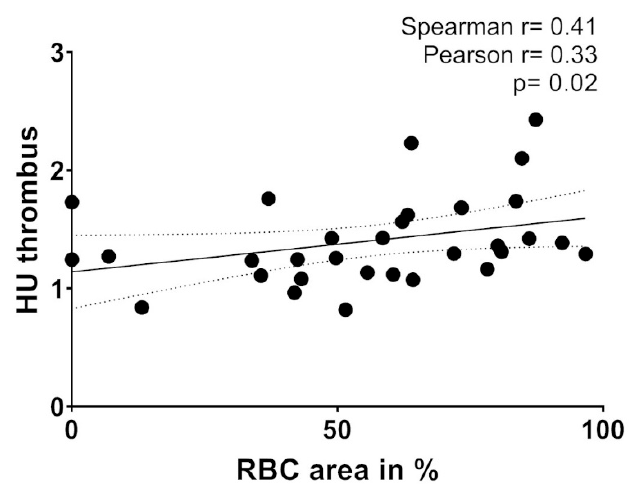
Figure 5. Correlation between the area of red blood cells (RBCs) (in % of total thrombembolus area) and relative HU (Hounsfield unit) density on non-contrast CT (NCCT). p = level of significance. r = correlation coefficient.